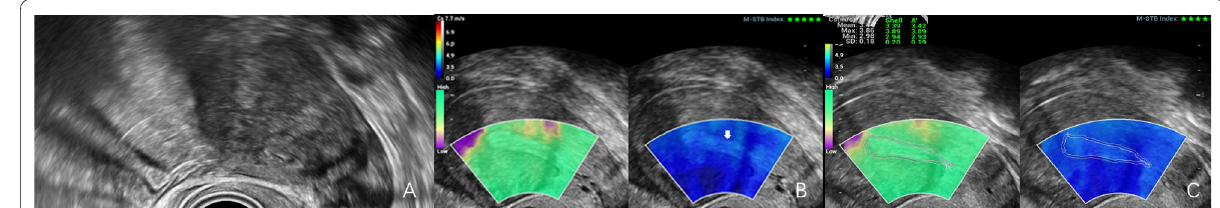
Fig. 5 SWE used to display of uterus junctional zone (JZ). A Transvaginal grayscale ultrasound showed JZ appeared as a fuzzy region. B JZ in SWE can be seen clearly (marked with a white arrow) and distinguished from the surrounding healthy tissue. C The endometrium is delineated, and then, the JZ is delineated by shell function key and the shear wave speed (Cs) of both regions can be obtained